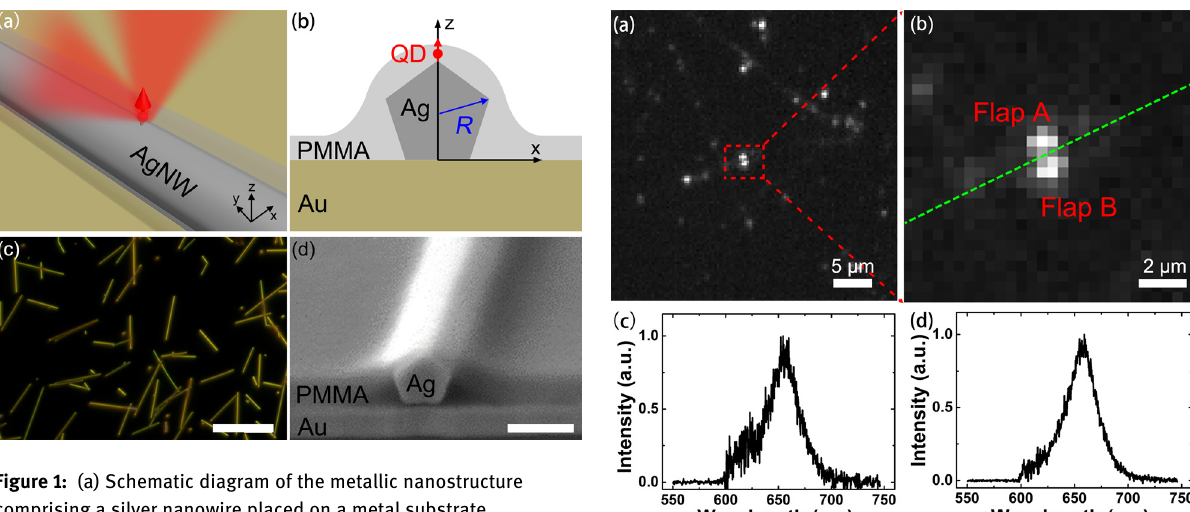
polarizer. The polarizations of the two splitting fl aps (Flap A and B) are perpendicular to the silver nanowire (denoted by the green dashed lines in Figure 2e and f). The degrees of linear polarization of Flap A and Flap B are greater than